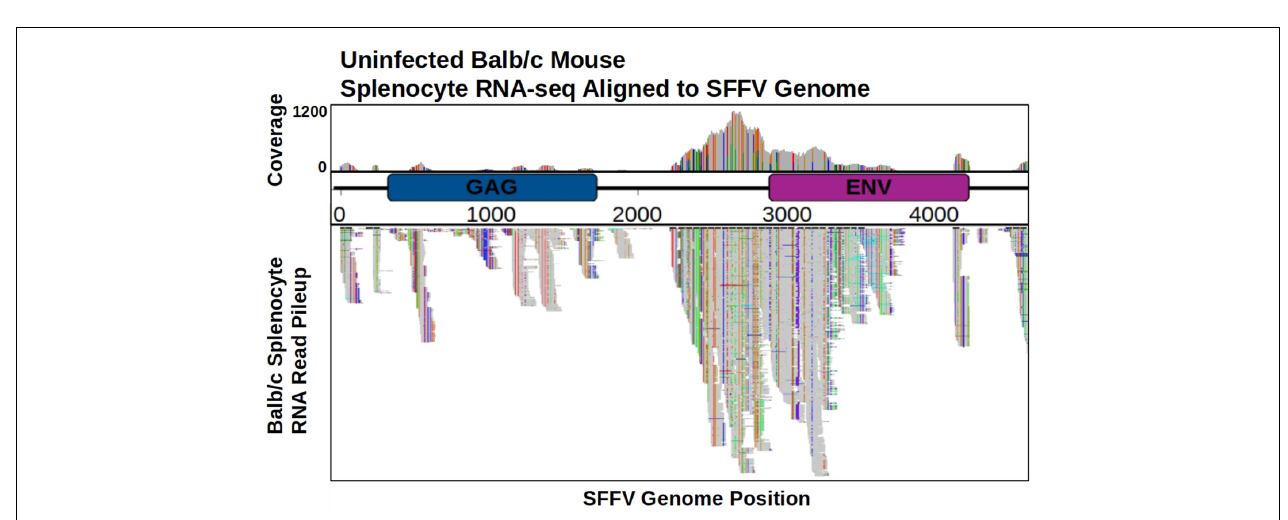
FIGURE 4 | Expression of EnMuLVs from uninfected mouse splenocytes aligned to SFFV-BC reference genome. Position of read alignment is on the X axis with a schematic of the annotated SFFV-BC genes. Gray profile above the genome map shows relative coverage of EnMuLV RNA-seq and gray bars below the genome map show actual read alignments. The maximum of EnMuLV read coverage across the SFFV-BC genome is 1112 from a total of 26M initial read pairs. SFFV sites with differences between aligned EnMuLV reads and the SFFV-BC reference sequence are shown as vertical colored bars within the gray coverage profile and aligned reads, with changes noted by color: green-A, blue-C, red-T, gold-G, and purple-Insertions. GAG, group antigen; ENV, envelope gene.